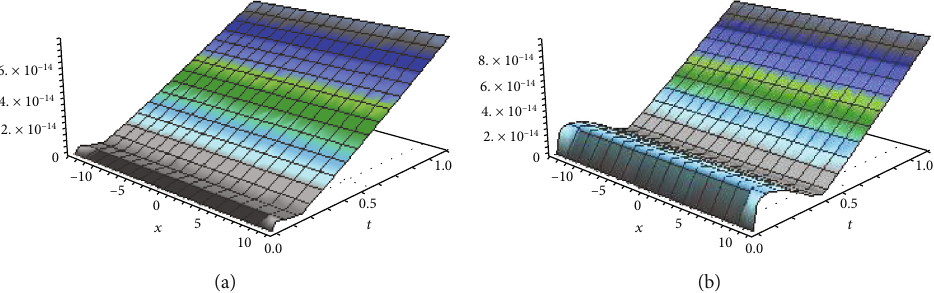
− u u − u 2 q HAM j and (b) j 2 NIM j .